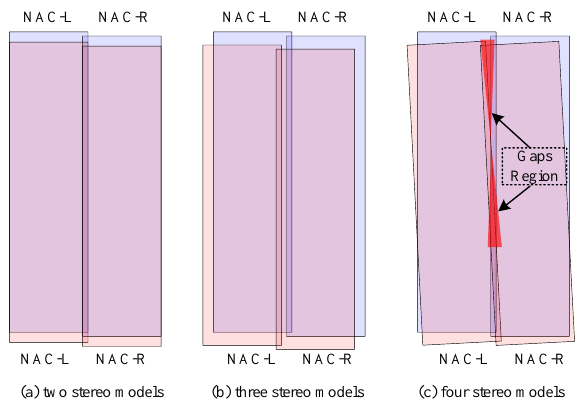
Figure 1. Different theoretical model configurations for a stereo pair of NACs. In fact, the last case of four stereo models are the most common one. Please note the irregular overlapping region, which may probably cause gaps because of insufficient matches